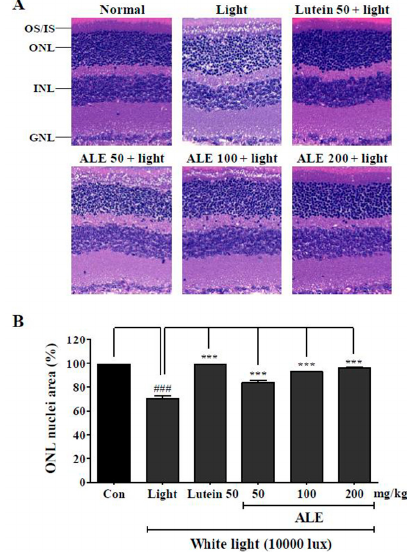
Figure 5. Inhibitory e ff ect of ALE on light-induced retinal damage. ( A ) Representative hematoxylin and eosin (H&E) stained images in light-induced age-related macular degeneration (AMD) model. BALB / c mice ( n = 6) were treated with vehicle, lutein (50 mg / kg), or ALE (50, 100, and 200 mg / kg) for 4 weeks and exposed to white light at 10,000 lux in light cages for 6 h. After exposure, mice were given inhaled anesthesia with isoflurane immediately and were euthanized to remove the eyes. ( B ) Stained region in ONL layer was calculated using metamorph and expressed in ONL nuclei area (%). The values represent the mean ± SD ( n = 3). ### : p < 0.001 vs control group; *** p < 0.001 vs light exposure group, one-way ANOVA with Tukey’s post hoc test. OS, outer segments; IS, inner segments; ONL, outer nuclear layer; INL, inner nuclear layer; GCL, ganglion cell